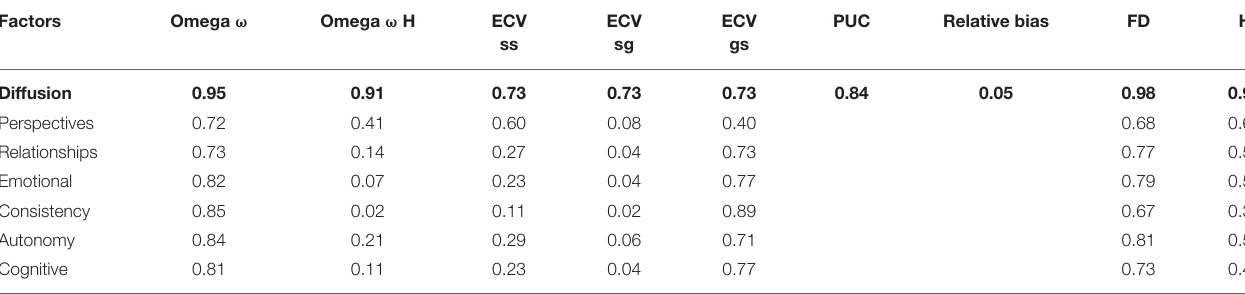
TABLE 3 | Reliability indices for bifactor confirmatory analysis. Factors